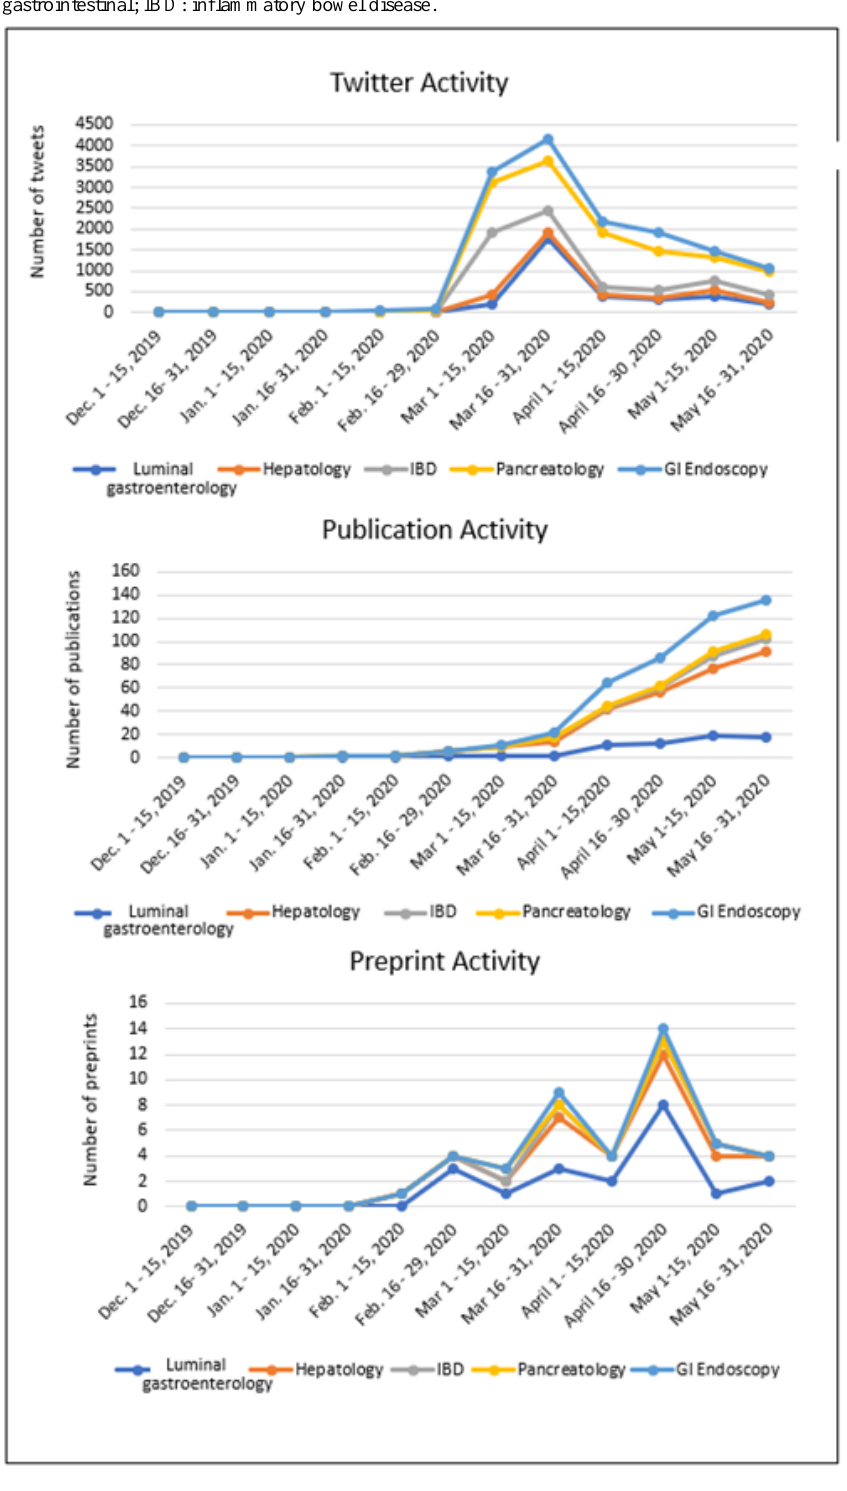
Figure 5. Trend of COVID-19 and gastroenterology subspecialty–related Twitter, publication, and preprint activity. Trend in the number of (A) tweets, (B) publications, and (C) preprints published pertaining to COVID 19 and gastroenterology subspecialty topics at half-month intervals between December 2019 and May 2020. GI: gastrointestinal; IBD: inflammatory bowel